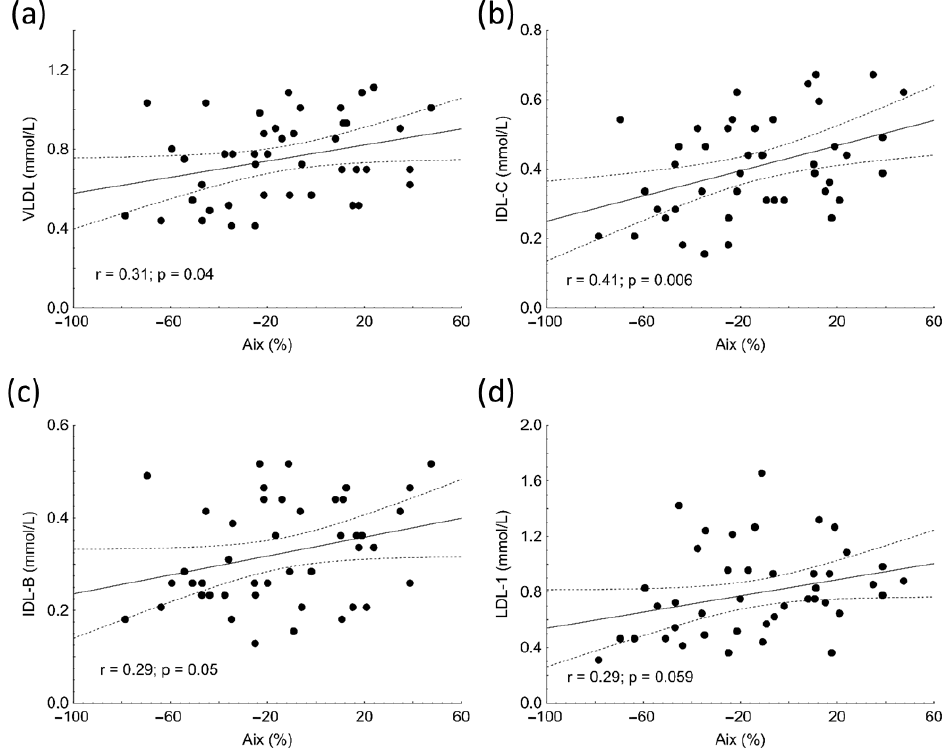
Figure 1. Correlations between levels of very low-density lipoprotein (VLDL) ( a ), intermediate density lipoprotein (IDL-C) ( b ), IDL-B ( c ), low-density lipoprotein-1 (LDL1) ( d ) subfractions and augmentation index (Aix) in patients with systemic lupus erythematosus (SLE). There were significant negative correlations between hsCRP (r = − 0.4; p = 0.006), TG (r = − 0.36; p = 0.02), LDL-C (r = − 0.31; p = 0.03), ApoB100 (r = − 0.34; p = 0.02), VLDL (r = 0. − 36; p = 0.01), LDL-2 subfraction (r = − 0.32; p = 0.03) and FMD in patients (Figure 2).